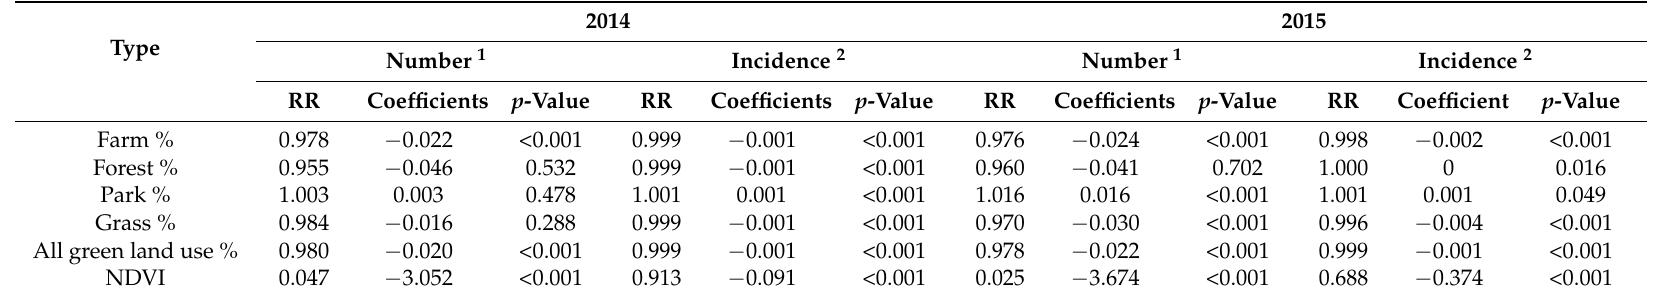
Table 4. The Association between Surrounding Greenness and the Dengue Epidemics in 2014 and